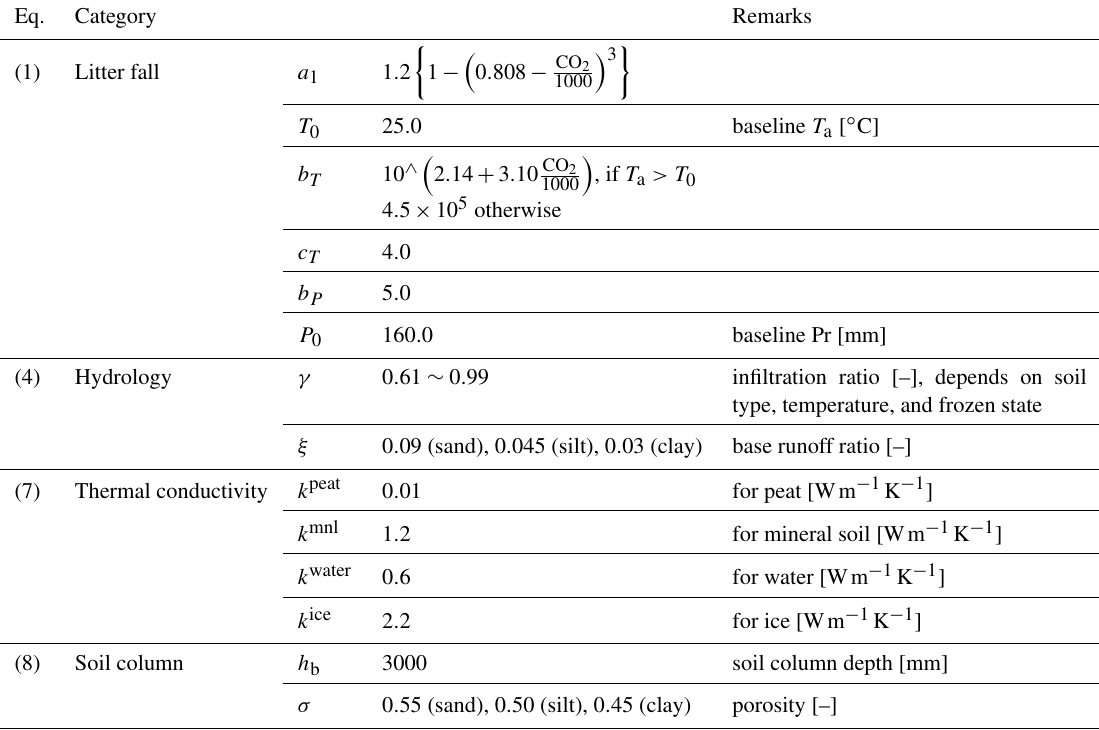
Figure 2. Distribution of litter fall, carbon input to the “subsurface” box, for a given mean annual air temperature ( T a ) and annual total precipitation (Pr) pairs. (a) Distribution of litter fall outputs calculated by biogeochemical models and normalized to the respective maximum value: (a) VISIT, (b) Biome-BGC, (c) SEIB-N, and (d) CHANGE for global land areas, except for CHANGE, the result of which covered only land areas north of 50 ◦ N. The scale is shown on the left-hand side of the colour bar. (e) The modelled litter fall distribution is based on simulated outputs for the functional shape and calibrated for absolute value by observation data. Note the vertical ranges are different for (e) . The scale is shown on the right-hand side of the colour bar. Table 1. List of parameters used in the model.